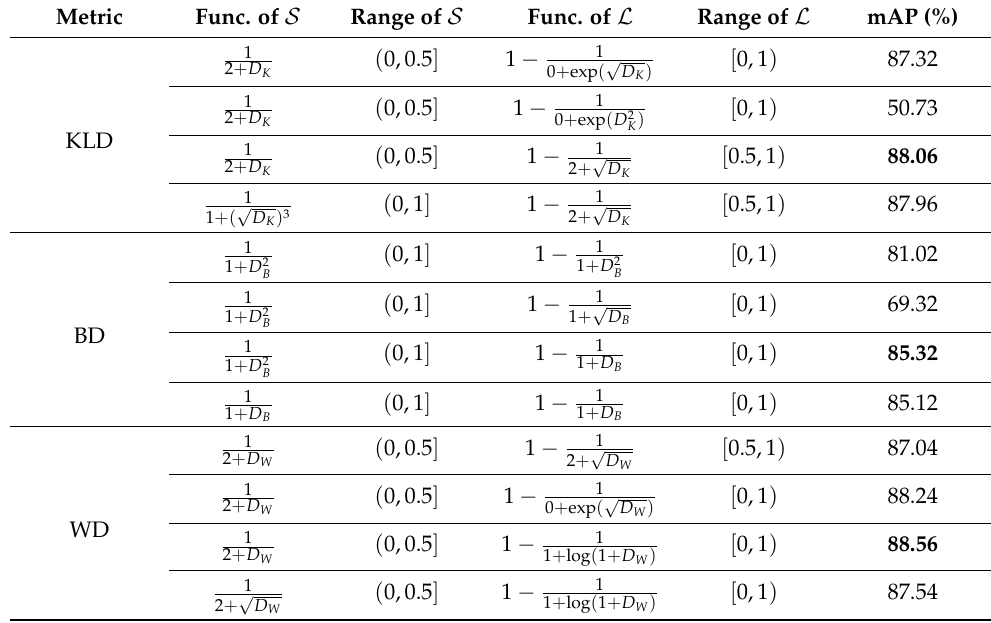
Table 1. Experiment results of normalized function design for label assignment ( S ) and regression loss ( L ) on HRSC2016.